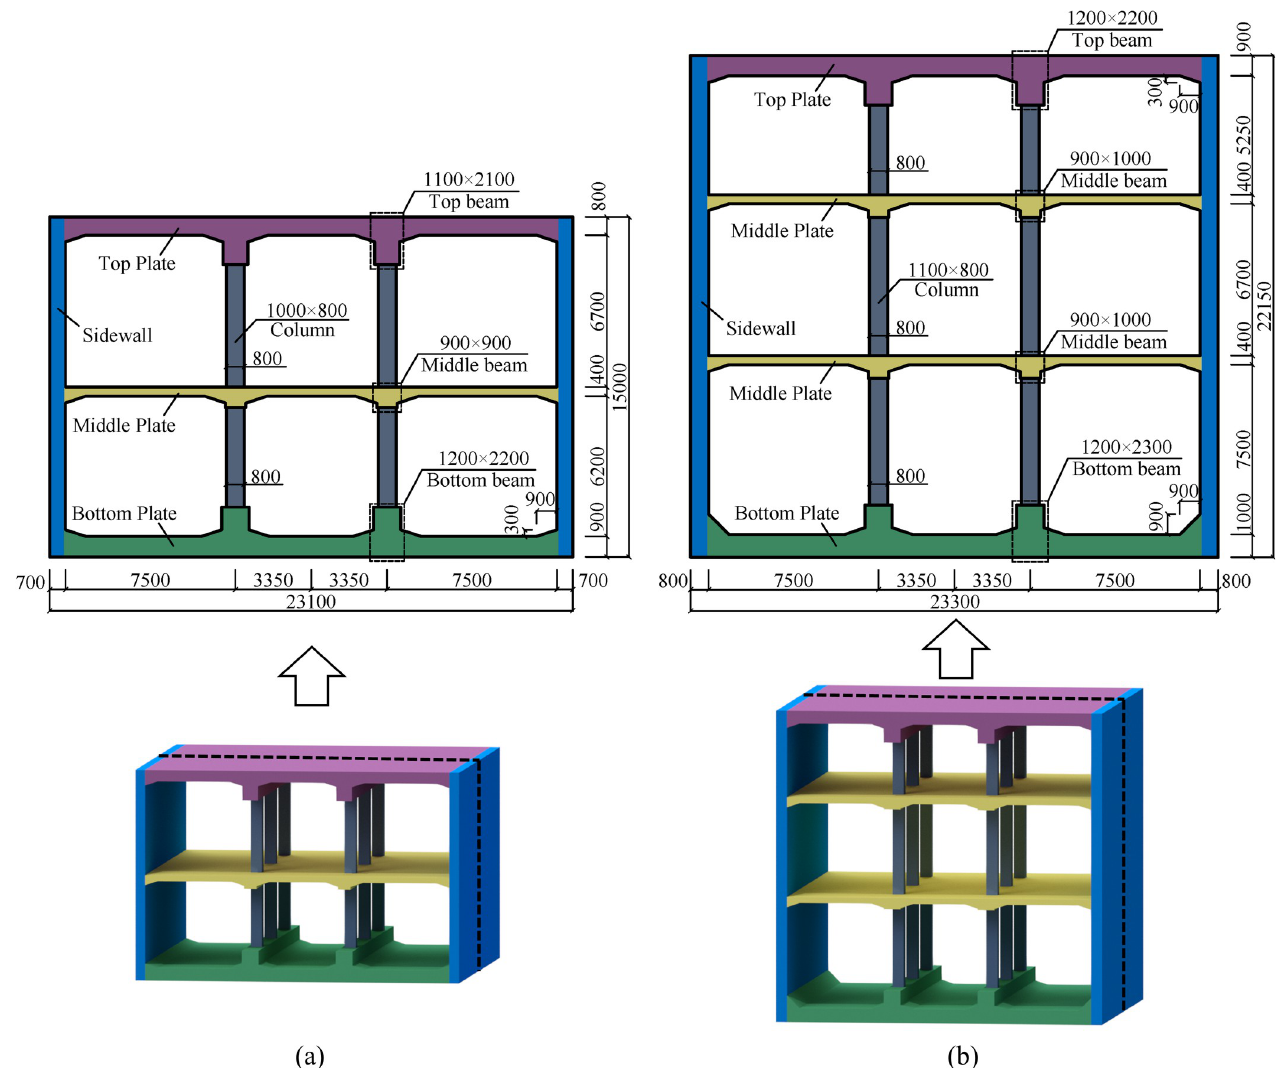
Fig 9. Cross-section of the underground structures (mm). (a) Double-storey station, (b) Three-storey station.